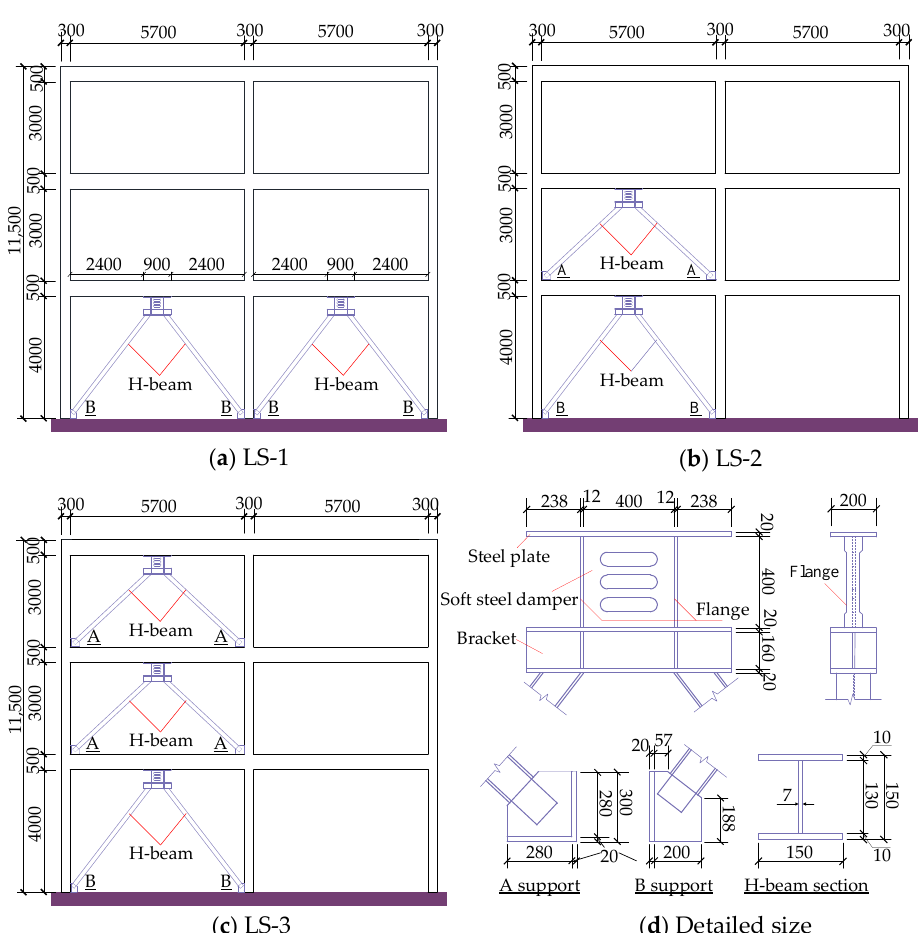
Figure 8. Layout schemes ( a )-( c ) and detailed size ( d ) of CSSDB systems for MD-RC frame (all dimensions in